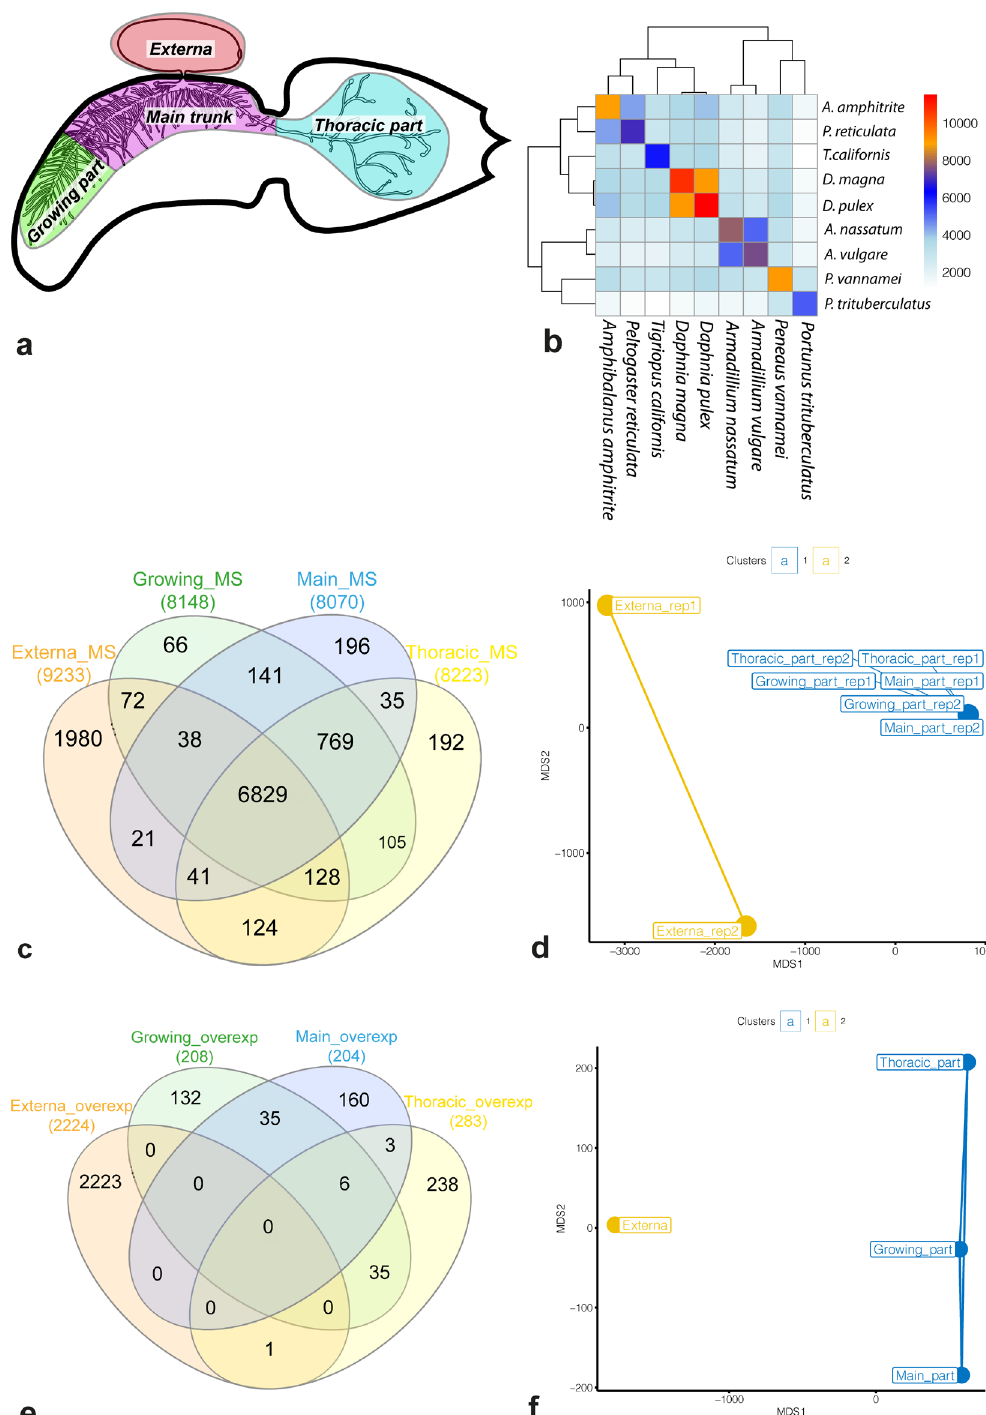
Figure 1. Molecular signatures of female Peltogaster reticulata . ( a ) Generalized scheme of female P. reticulata in the host. Colour sectors indicate the body parts examined in our study: externa (red), growing part of interna (green), main trunk of interna (purple), and thoracic part (blue). ( b ) The number of common OMA groups. The colour key on the heatmap shows the number of shared OMA groups between species. ( c , e ) Venn diagram for a set of genes either included in molecular signatures of the body parts ( c ) or over-expressed in the body parts ( e ). ( d , f ) Multidimensional scaling (MDS) plots for molecular signatures ( d ) and sets of over-expressed genes ( f ). Different clusters in MDS plots are marked with colours. Abbreviations: MS/overexp – the molecular signature or set of over-expressed genes for the body part, respectively; rep1/2 – biological replication